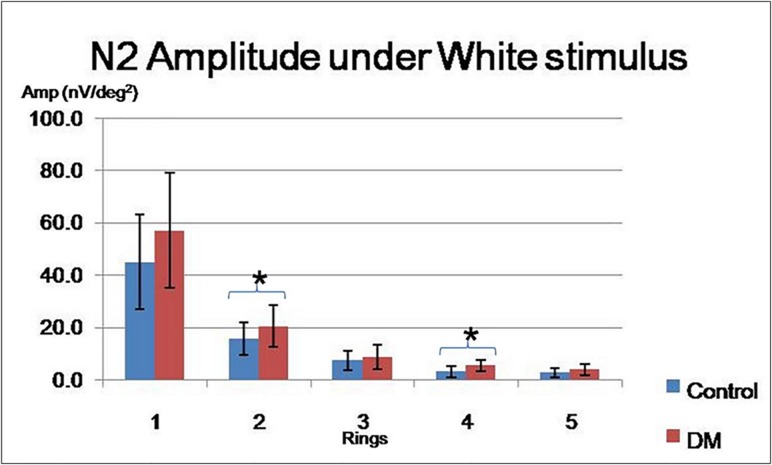
The N2 amplitude (mean ± SD) in the control and diabetic groups under the white condition (* indicates parameters that achieved statistically significant level with p < 0.05).